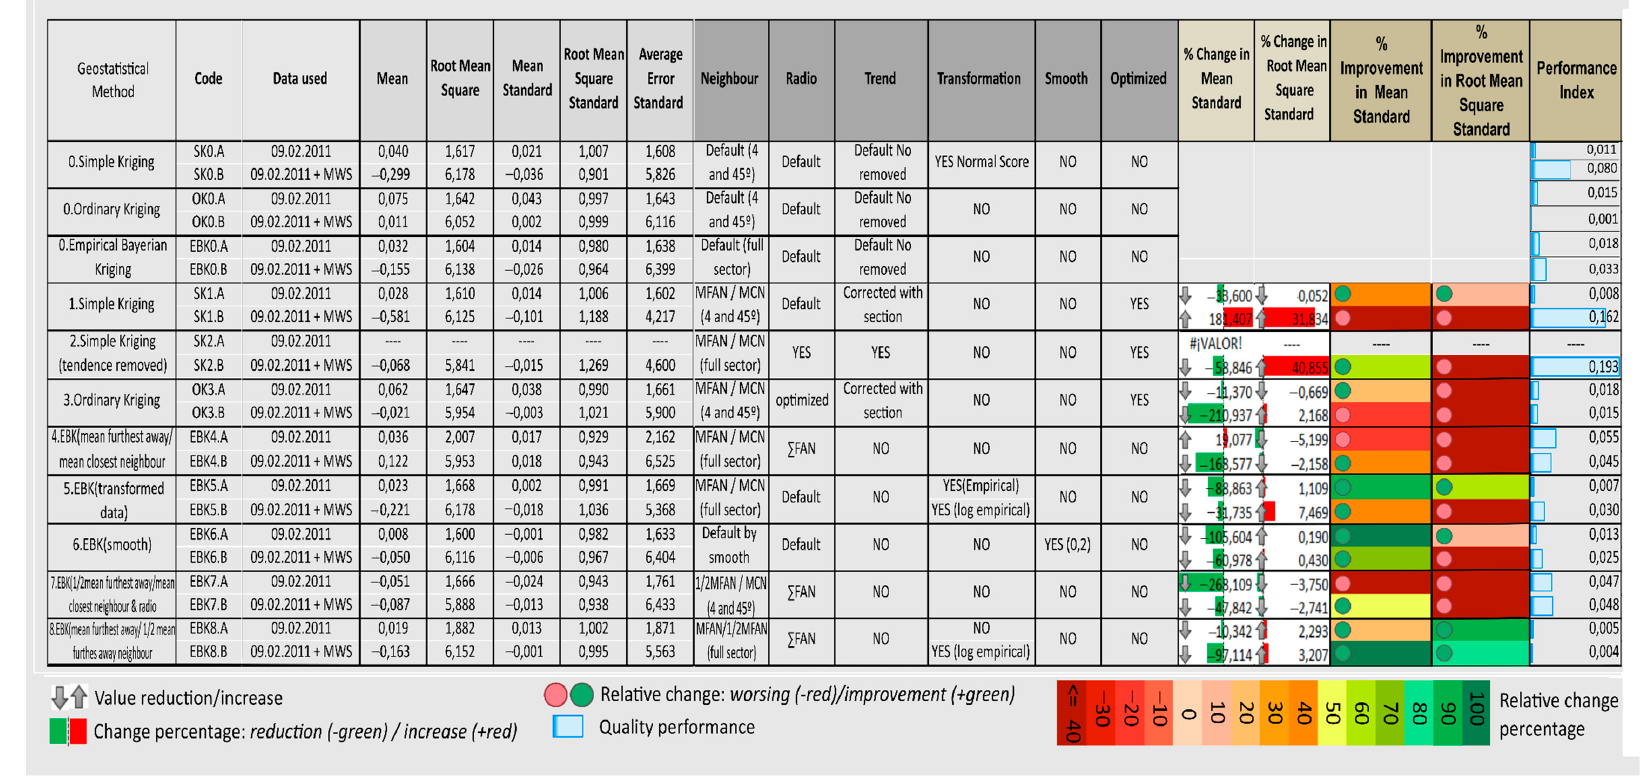
Figure 8. Statistical analysis, parameters definition, and comparison of eight geostatistical interpolation models for suspended particulate matter (data set A) and its inputs MWS into the marine system (data set B). In colors, improvement, and performance of the model. Interpolation methods: SK (Simple Kriging), OK (Ordinary Kriging), and EBK (Empirical Bayesian Kriging). Neighborhood definition: maximum neighbor/minimum neighbor; MFA (mean of furthest away neighbor); MCN (mean of closest neighbor); 1/2 MFAN (half of furthest away neighbor); Sector type of neighbor research full sector or 4 sections in 45°. Radio type: default; optimized; ∑ FAN (sum of furthest away neighbors at each sample point). When a trend, a first-order trend is removed. When smooth, the factor is 0.2. For further details on parameters definition and model comparison, see Supplementary Materials Table 1.